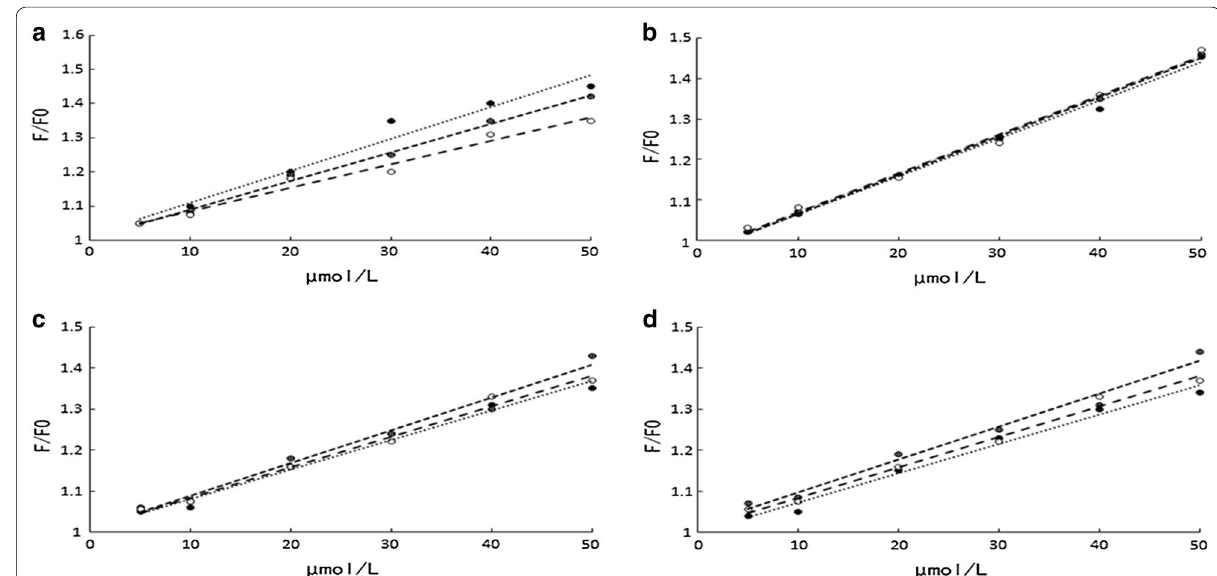
Fig. 2 The Stern–Volmer curves of Cyanidin-3- O -arabinoside ( a ), Cyanidin-3- O -galactoside ( b ), Cyanidin-3- O -glucoside ( c ) and Cyanidin-3- O -Xyloside ( d ) at 297, 317 and 337 K